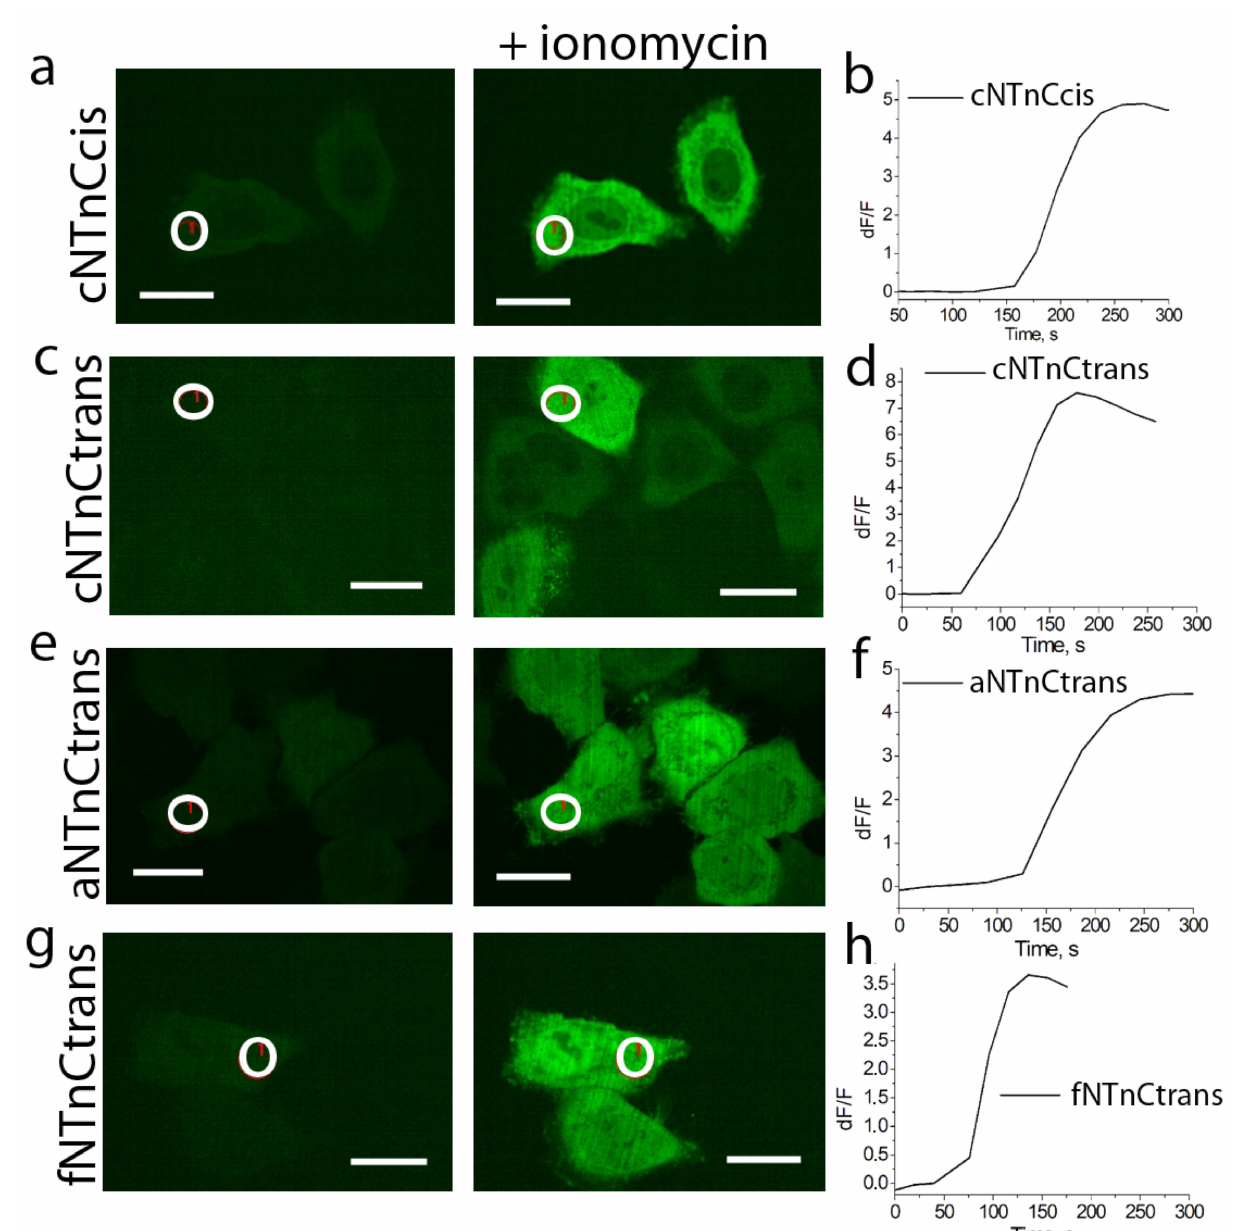
Figure 3. Response of NTnC-like variants with truncated troponin C from hummingbird ( a – d ), cheetah ( e , f ), and falcon ( g , h ) to Ca 2+ elevation in HeLa cells induced by ionomycin addition. Left, confocal images of HeLa cells expressing GECIs in the green fluorescence channel (488 nm excitation) before and after ionomycin addition. Right, the graphs show the time-lapse changes in green fluorescence as a result of the addition of 5 µ M ionomycin. The graphs illustrate the changes in green fluorescence in the areas indicated with white circles. Scale bars, 200 µ